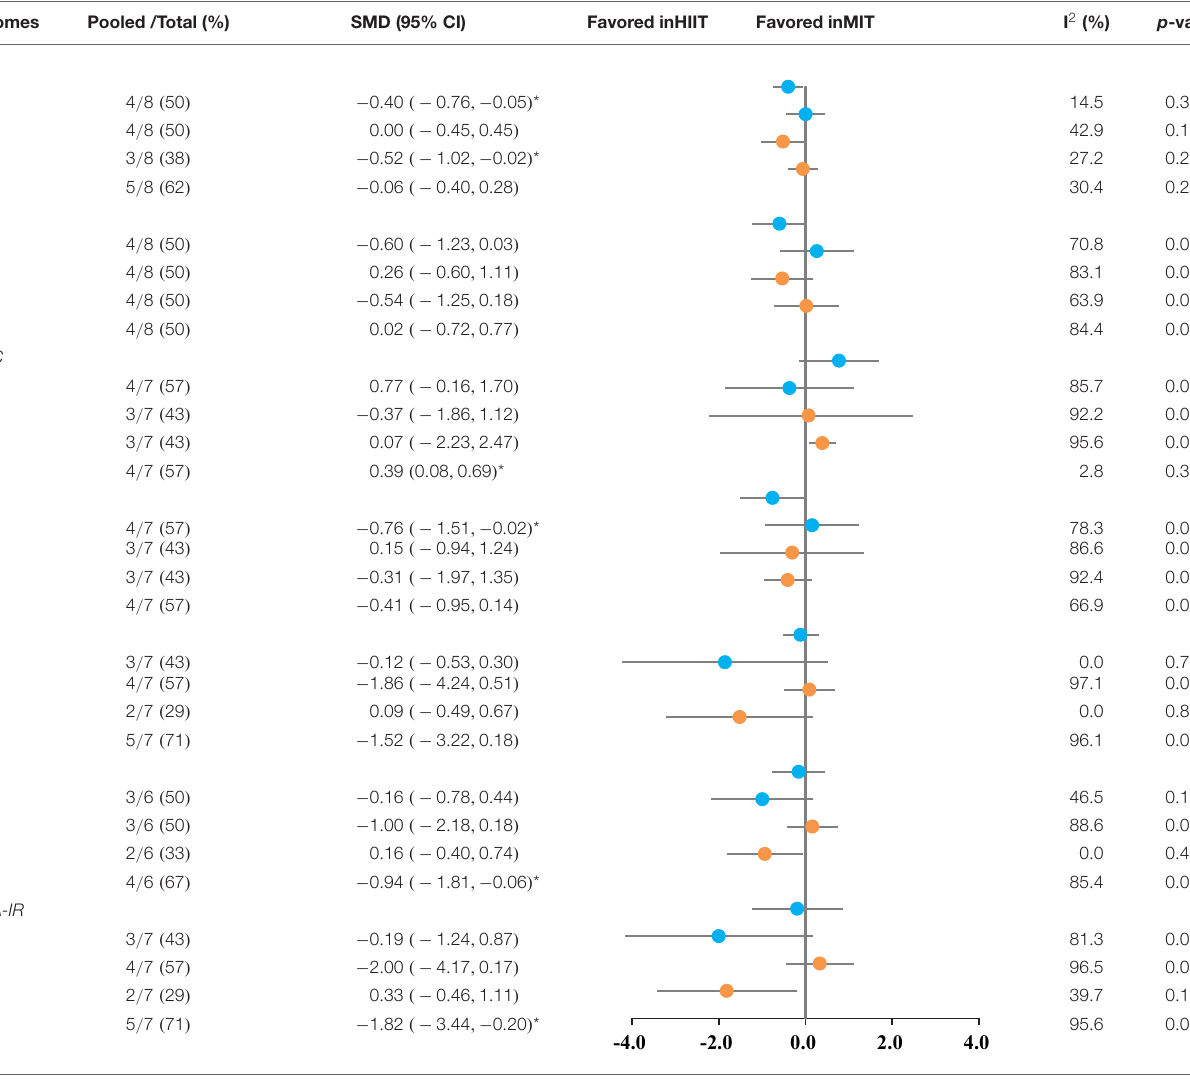
TABLE 4 | Subgroup analysis of HIIT vs. MIT on glycolipid outcomes.